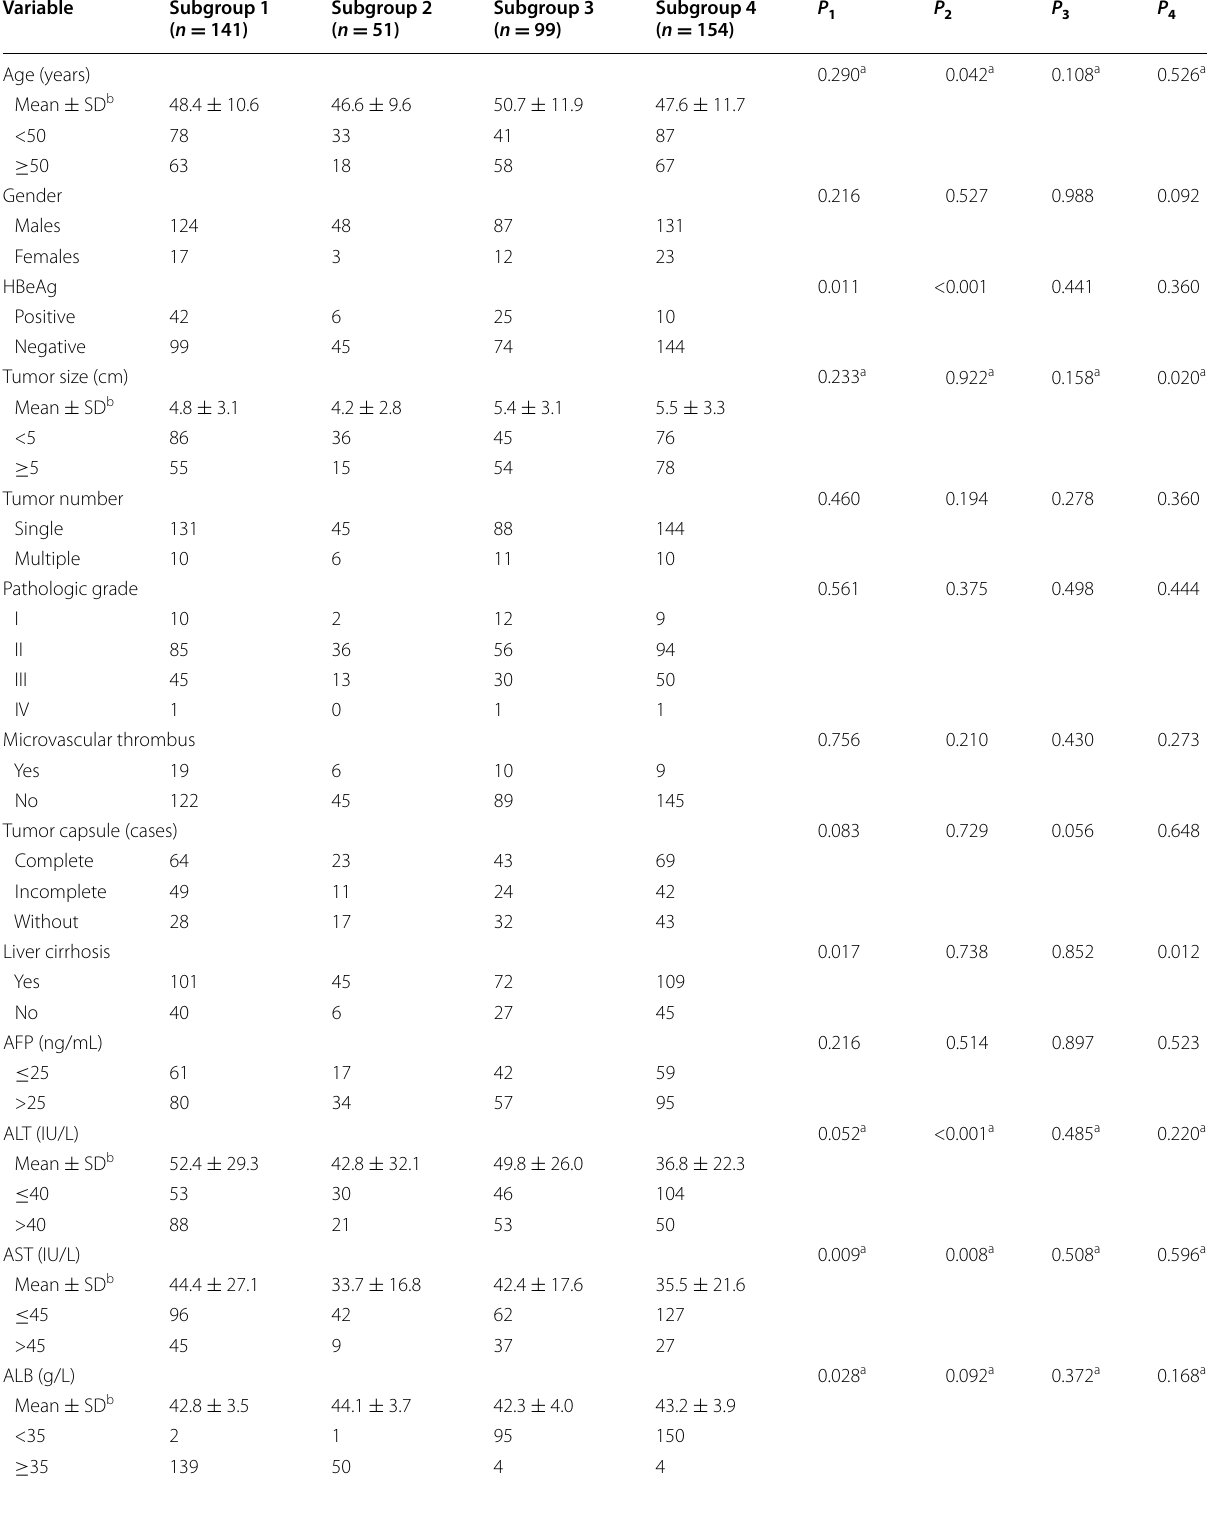
Table 3 Comparison of clinicopathologic characteristics among the